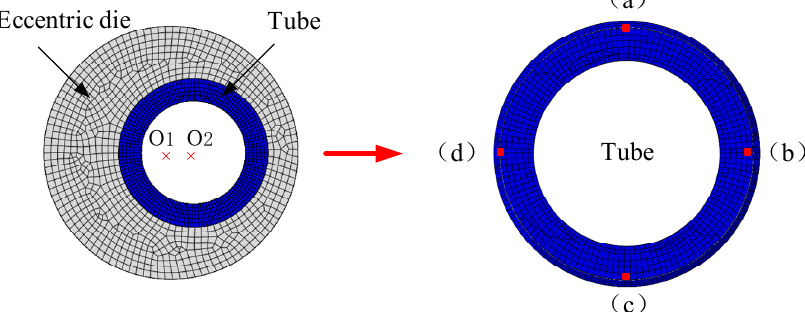
Figure 10. Sampling locations for stress analysis of tubing V-groove section.